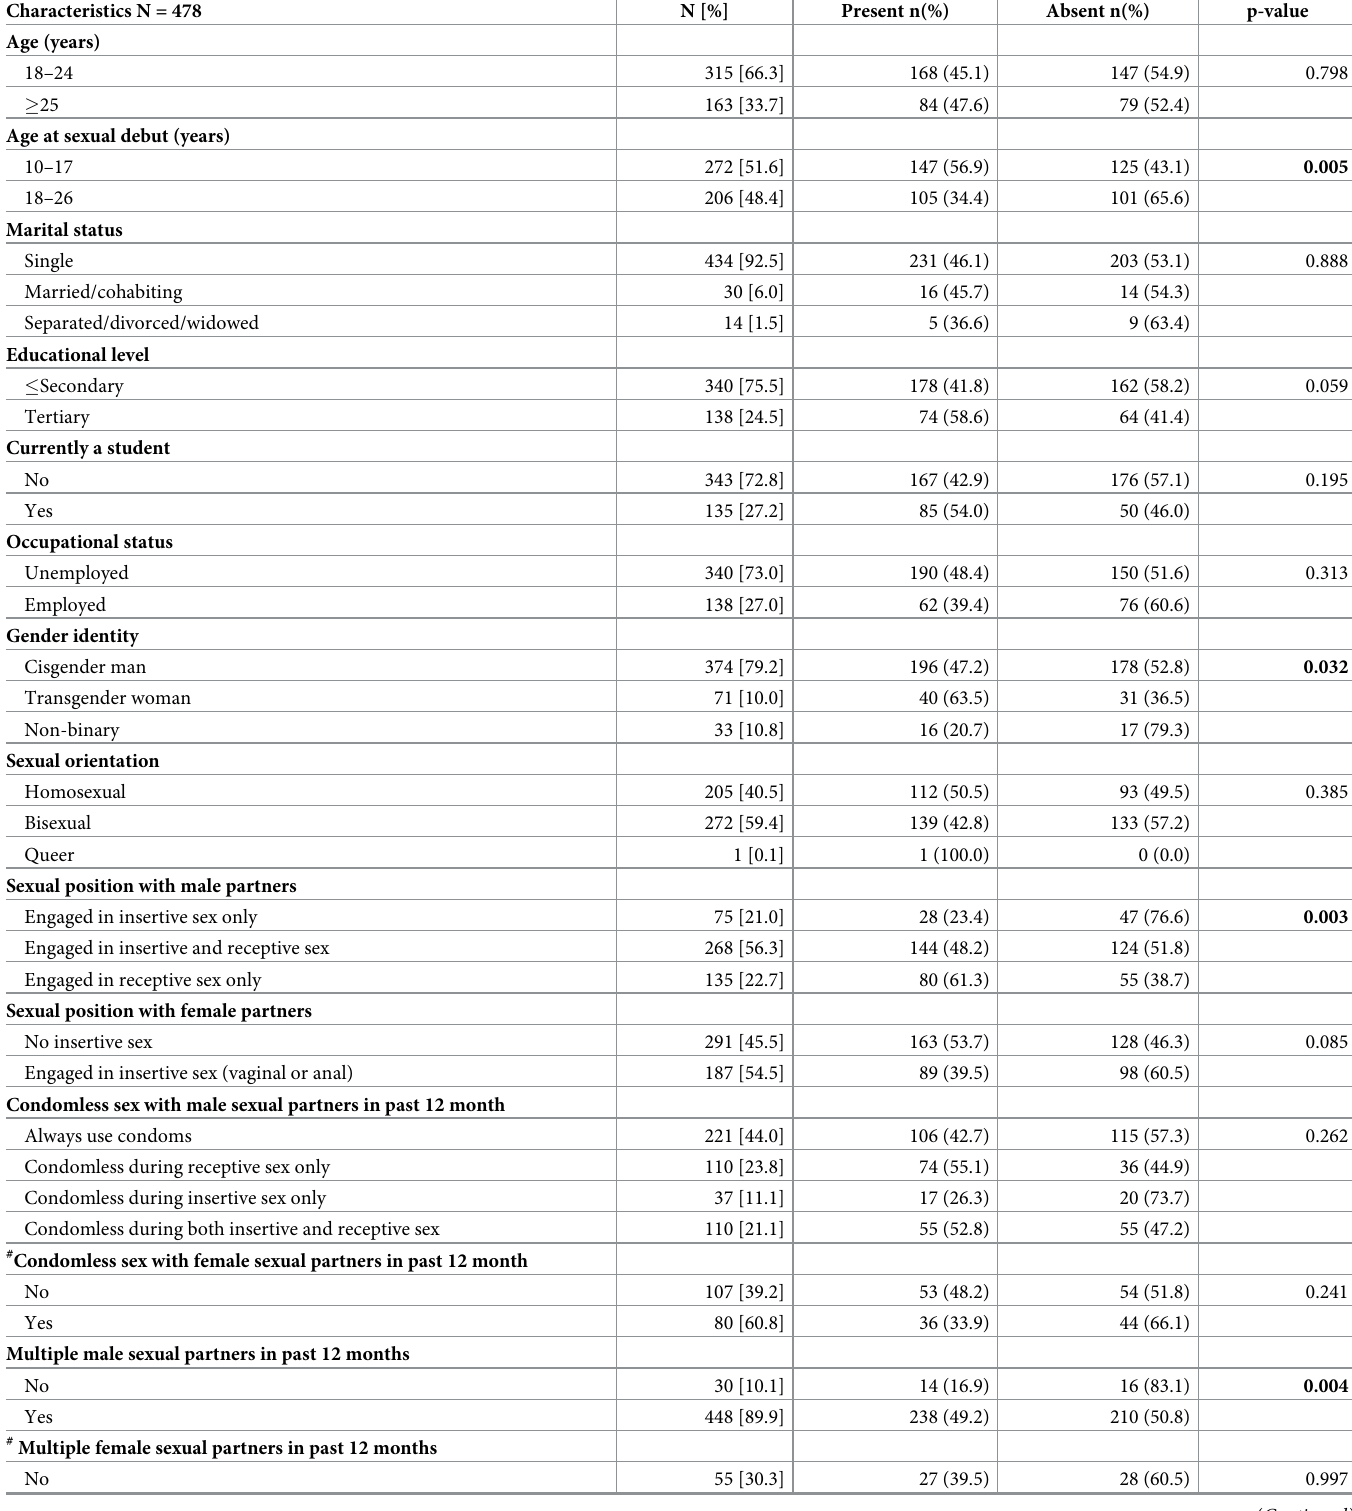
Table 1. Socio-demographics and sexual risk behaviors of anogenital warts among MSM. Characteristics N =